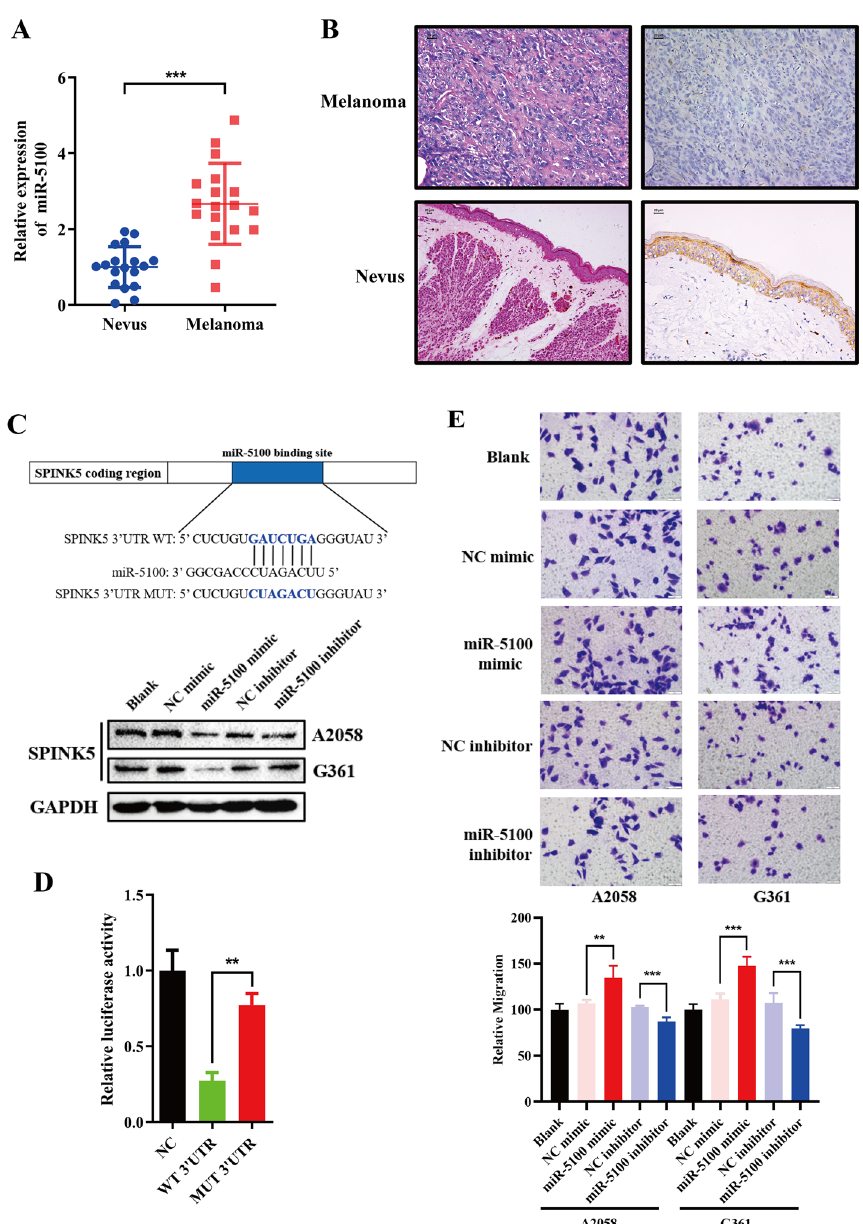
Fig. 1 miR-5100 modulates melanoma cell EMT by targeting SPINK5–STAT3 pathway. A , B Expression of miR-5100 and SPINK5 was measured by RT-qPCR and IHC in melanoma and nevus specimens. C , D The miR-5100 binding site in the 3 ′ -UTR of SPINK5 and matched mutations; miR-5100 modulates SPINK5 expression. Furthermore, a luciferase reporter assay was conducted in 293T cells to verify the interaction between miR-5100 and the SPINK5 binding site. E , F The metastasis inhibition effects of miR-5100 were measured by wound-healing and transwell assays. G miR-5100 modulates melanoma cell EMT process shown by EMT-related markers determined by western blot analysis. H , I Immunoblotting and IF analysis of STAT3, and phosphorylation of STAT3 in A2058 and G361 cell lines transfected with either a mimic or an inhibitor of miR-5100. * p < 0.05, ** p < 0.01, *** p < 0.001 versus